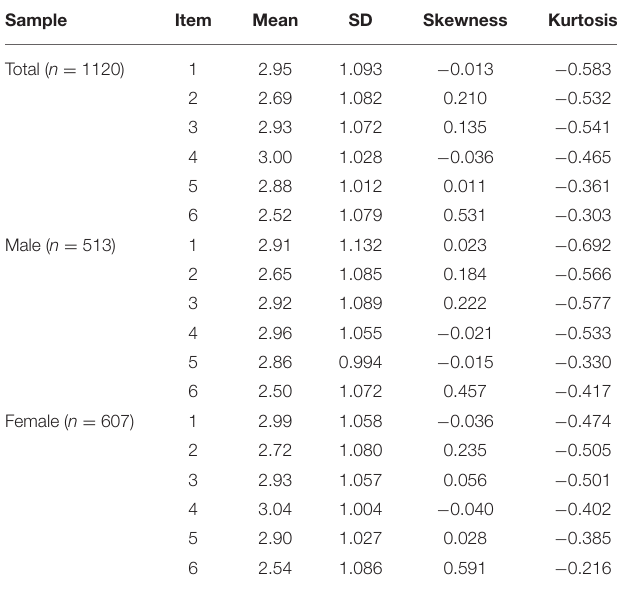
TABLE 1 | Descriptive statistics of the BSMAS.